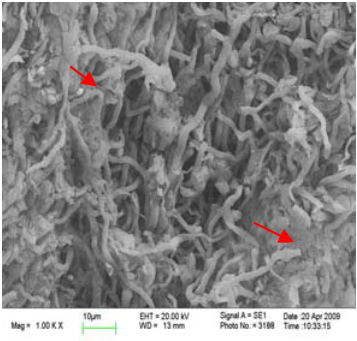
Figure 3. SEM micrograph of alkaline extraction residue at 1,000-fold